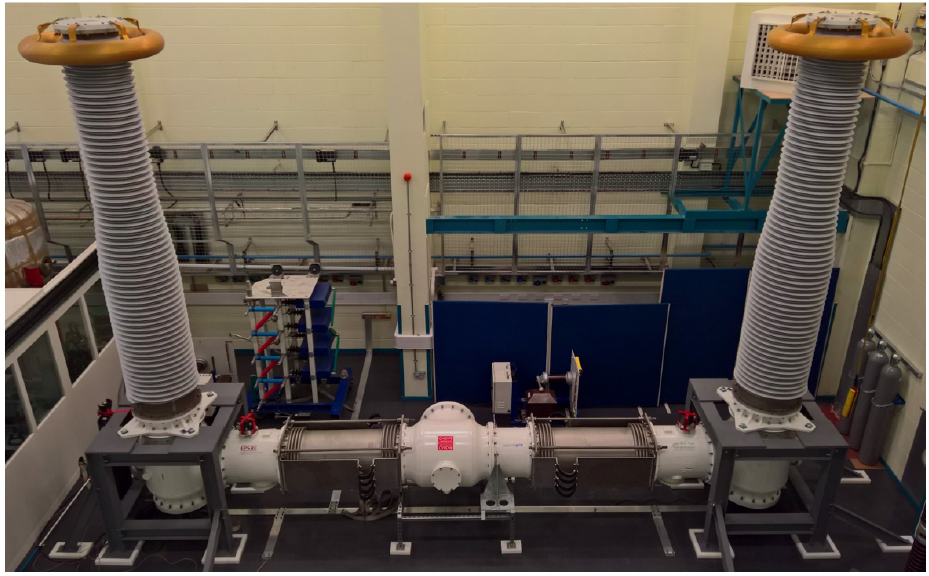
Figure 1. Gas insulated line demonstrator constructed and installed at Cardiff University.